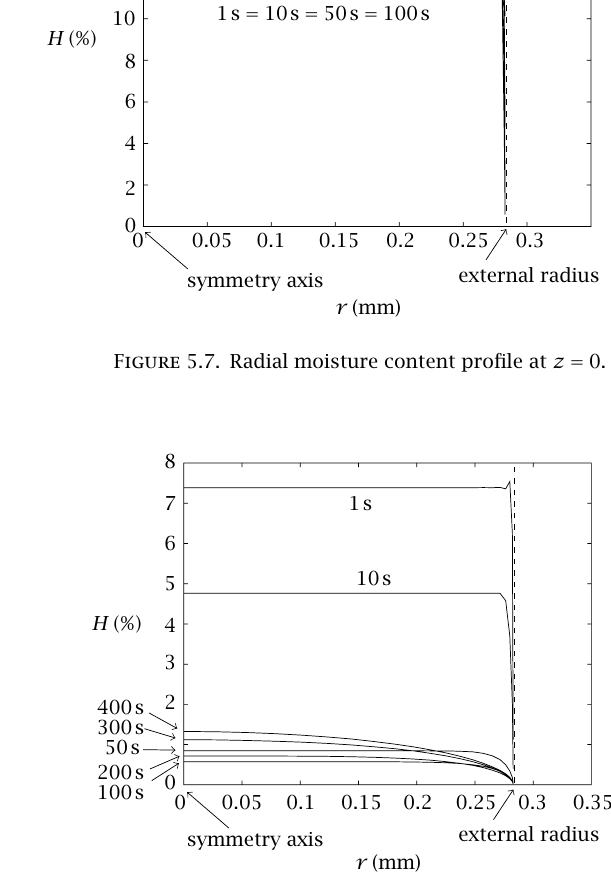
Figure 5.8 . Radial moisture content profile at press